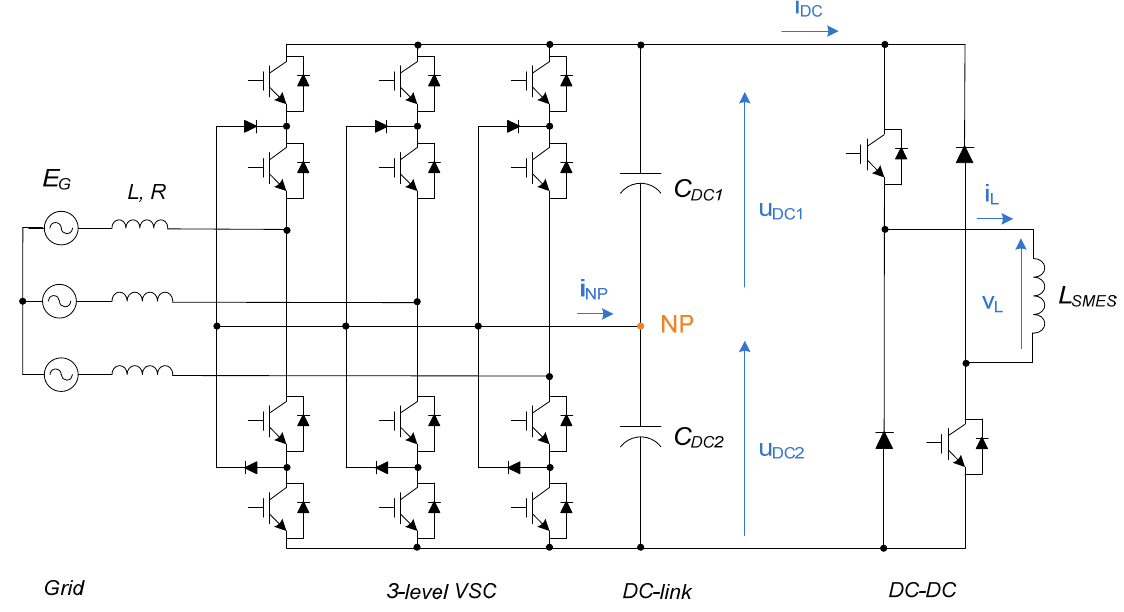
Figure 5. Power conditioning system based on a three-level VSC (NPC